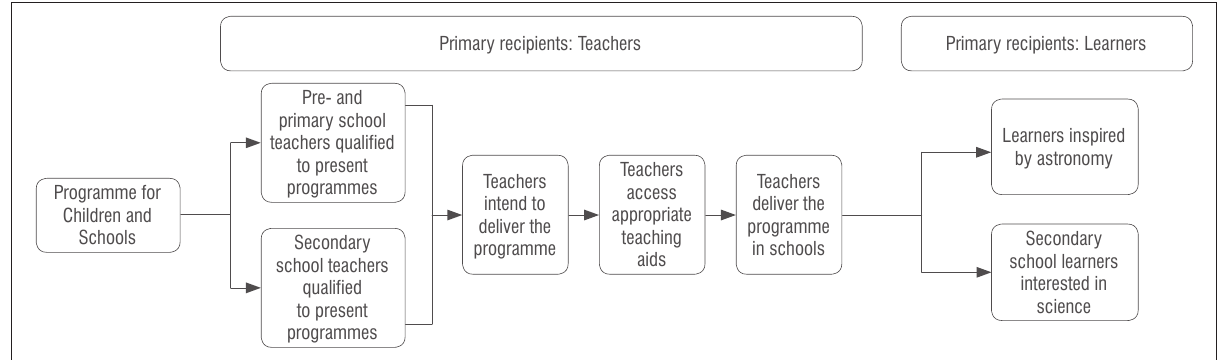
Programme theory for the Programme for Children and